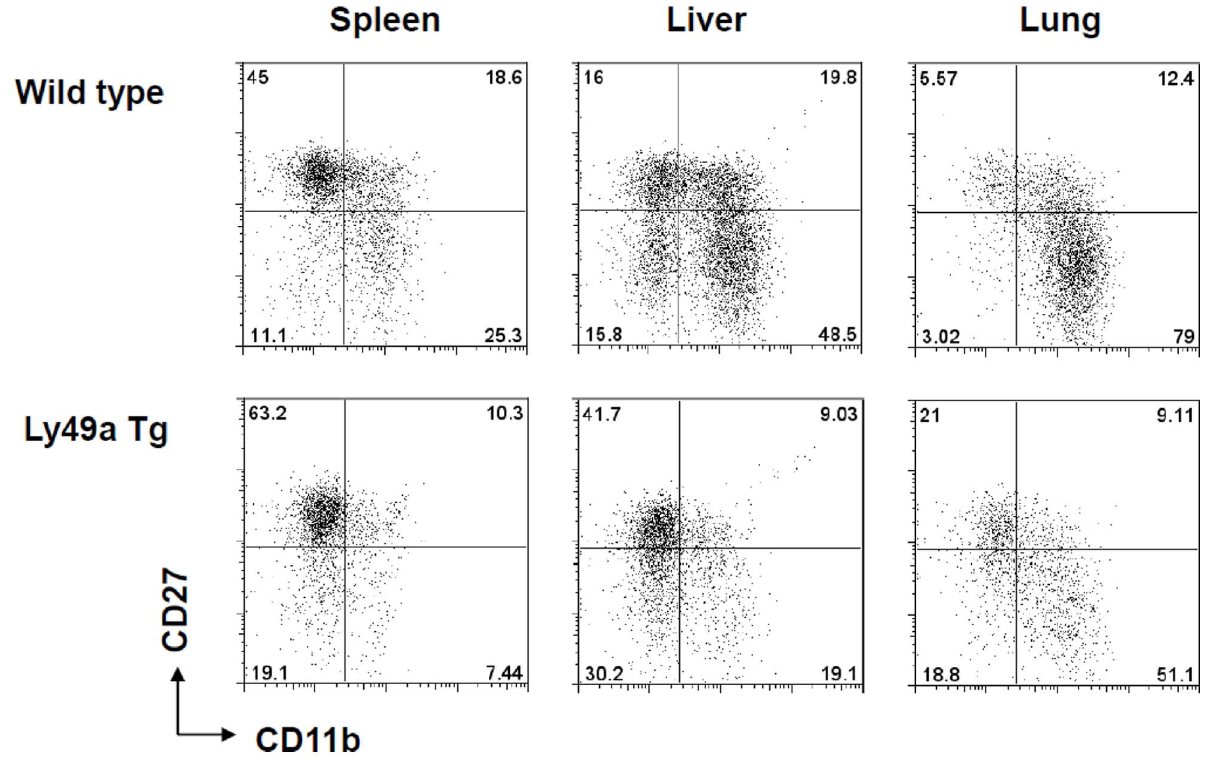
Figure 5. Organ-specific NK cell subset distribution in WT and Ly49A transgenic mice. Mononuclear cells were isolated from the spleens, livers and lungs of wild-type (upper row) and Ly49A transgenic mice (lower row) and analyzed by flow cytometry. Software gates were set to identify NK cells (NK1.1 + CD3–), which were then examined for the expression of the maturation markers CD27 and CD11b.